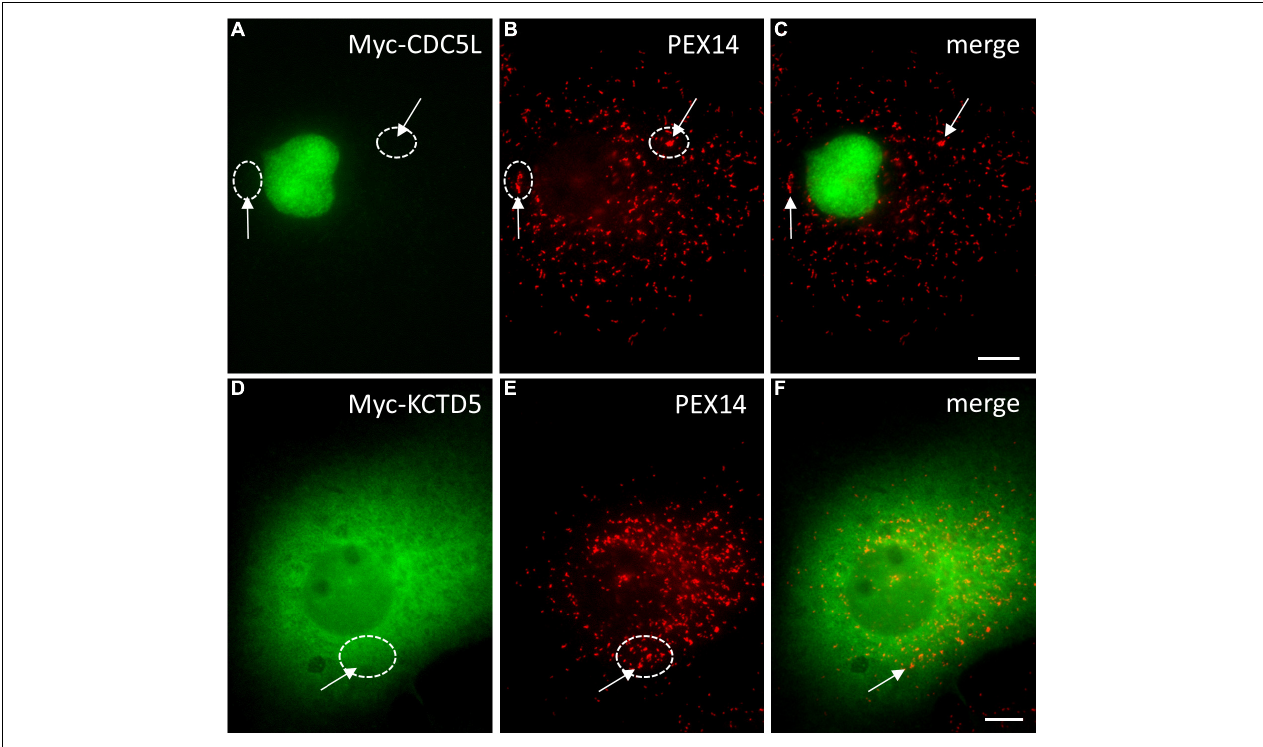
FIGURE 6 | Localisation of Hs CDC5L and Hs KCTD5 in COS-7 cells. COS-7 cells were transfected with Myc-CDC5L (A–C) or Myc-KCTD5 (D–F) and processed for immunofluorescence microscopy using anti-Myc and anti-PEX14 (peroxisomal marker) antibodies. Note that a peroxisomal localisation is not detected (arrows), even at large peroxisomal structures (circles). Bars, 10 µ